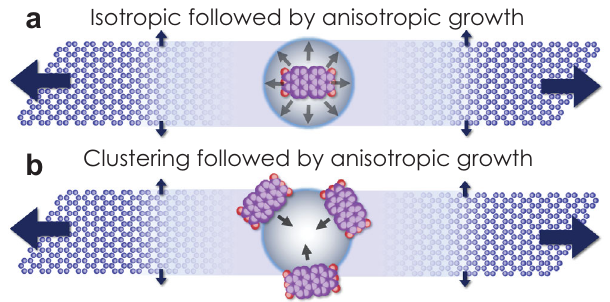
Fig. 3 Schematic depiction of two possible nanoribbon initiation pathways from PAH-derived seeds. Here, graphene is in blue and PTCDA molecule is in purple (carbon) and red (oxygen). a Individual PAH molecules or fragments of PAH molecules grow relatively isotropically from CH 4 to a critical size before anisotropic nanoribbon evolution begins. b Multiple PAH molecules or fragments of PAH molecules cluster to form seeds that are effectively larger in size (e.g., 1.7 nm for PTCDA, based on Fig. 2 data) that then initiate the anisotropic growth of